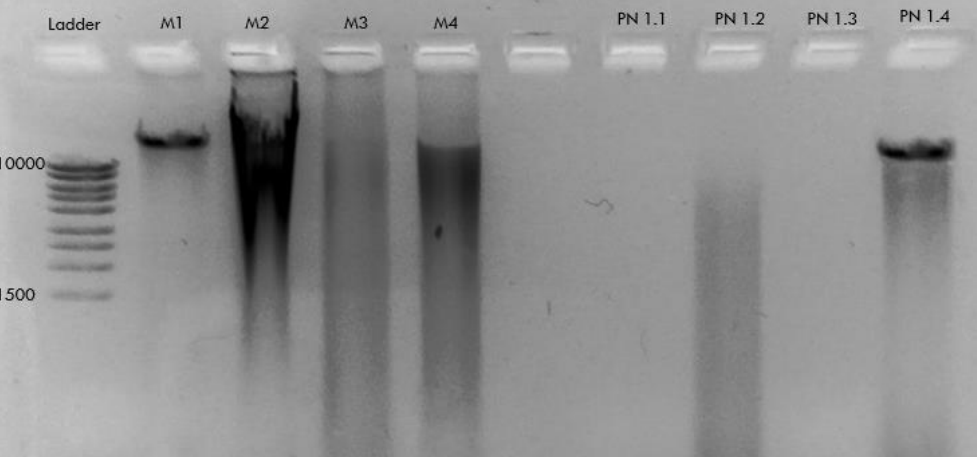
Figure 2. Agarose gel electrophoresis analysis of methods tested to extract DNA from Mytilus edulis (M) and Pinna nobilis (PN): CTAB (M1 and PN1.1), DNeasy PowerSoil Pro Kit (M2 and PN1.2) and DNeasy Plant Pro and Plant Kits (M3 and PN1.3), DNeasy Blood and Tissue Kit (M4 and PN1.4).